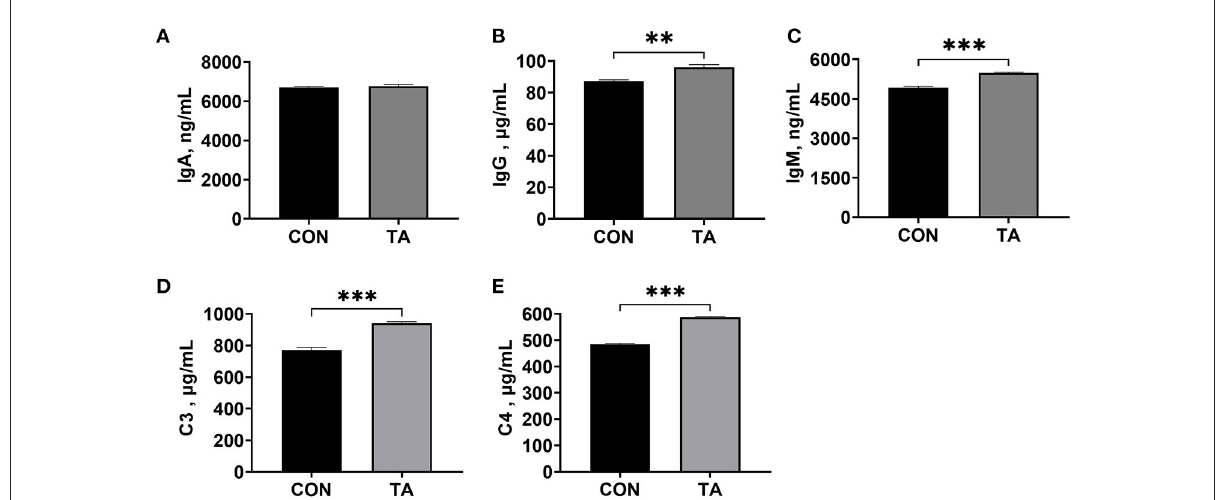
FIGURE2 Effects of dietary supplemented with microencapsulated TA from Galla Chinensis on serum immunoglobulins and complements concentrations of broiler chickens. (A) Immunoglobulin A (IgA), (B) Immunoglobulin G (IgG), (C) Immunoglobulin G (IgG), (D) Complement C3, (E) Complement